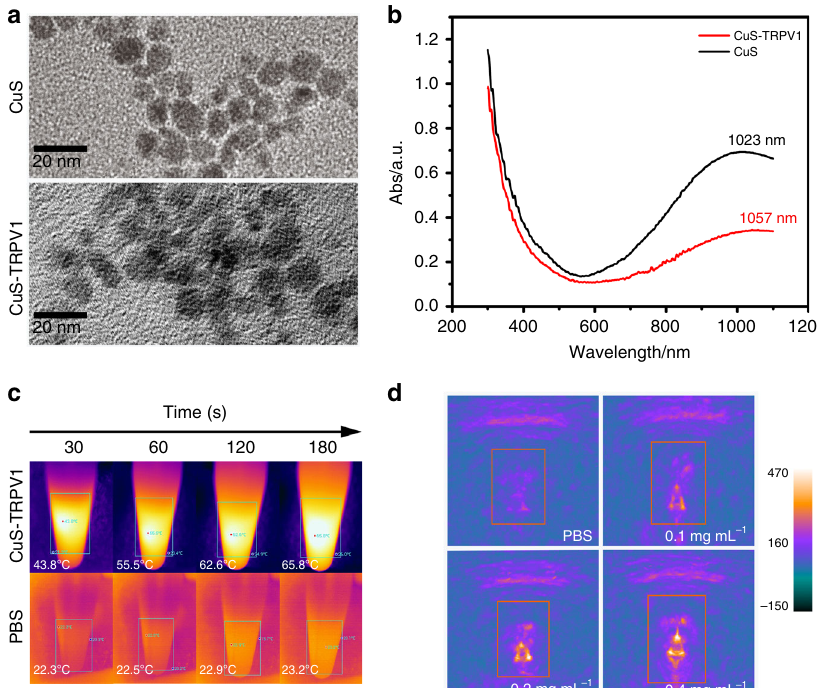
Fig. 2 Characterization of CuS-TRPV1 switch. a Transmission electron micrographs and b UV-Vis-NIR spectra of CuS and CuS-TRPV1. Scale bar = 20 nm. c Real-time infrared thermal imaging of CuS-TRPV1 and PBS with NIR irradiation (0.4 mg mL − 1 , 980 nm, 5 W cm − 2 for 180 s). d PA imaging of CuS-TRPV1 dispersed in PBS buffers with different concentrations (0, 0.1, 0.2, 0.4 mg mL − 1